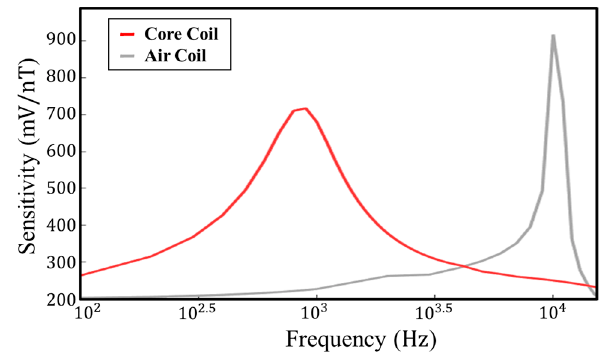
Figure 8. Sensitivity of air coil and core coil.